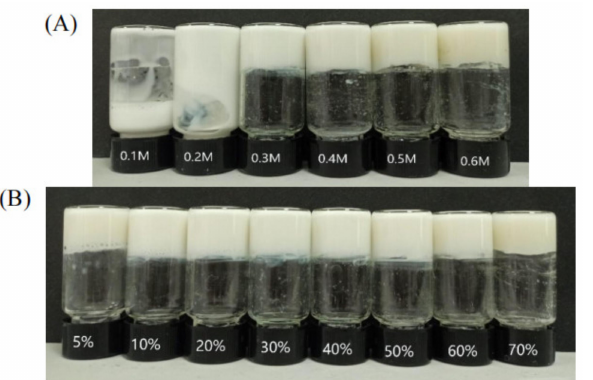
Figure 7. Digital photographs of n-hexadecane (50% oil) gel emulsions with different concentra- tions ( A ), Digital photograph of an aqueous n-hexadecane gel emulsion prepared at a constant concentration of 0.5 M but showing different oil mass fractions ( B ).